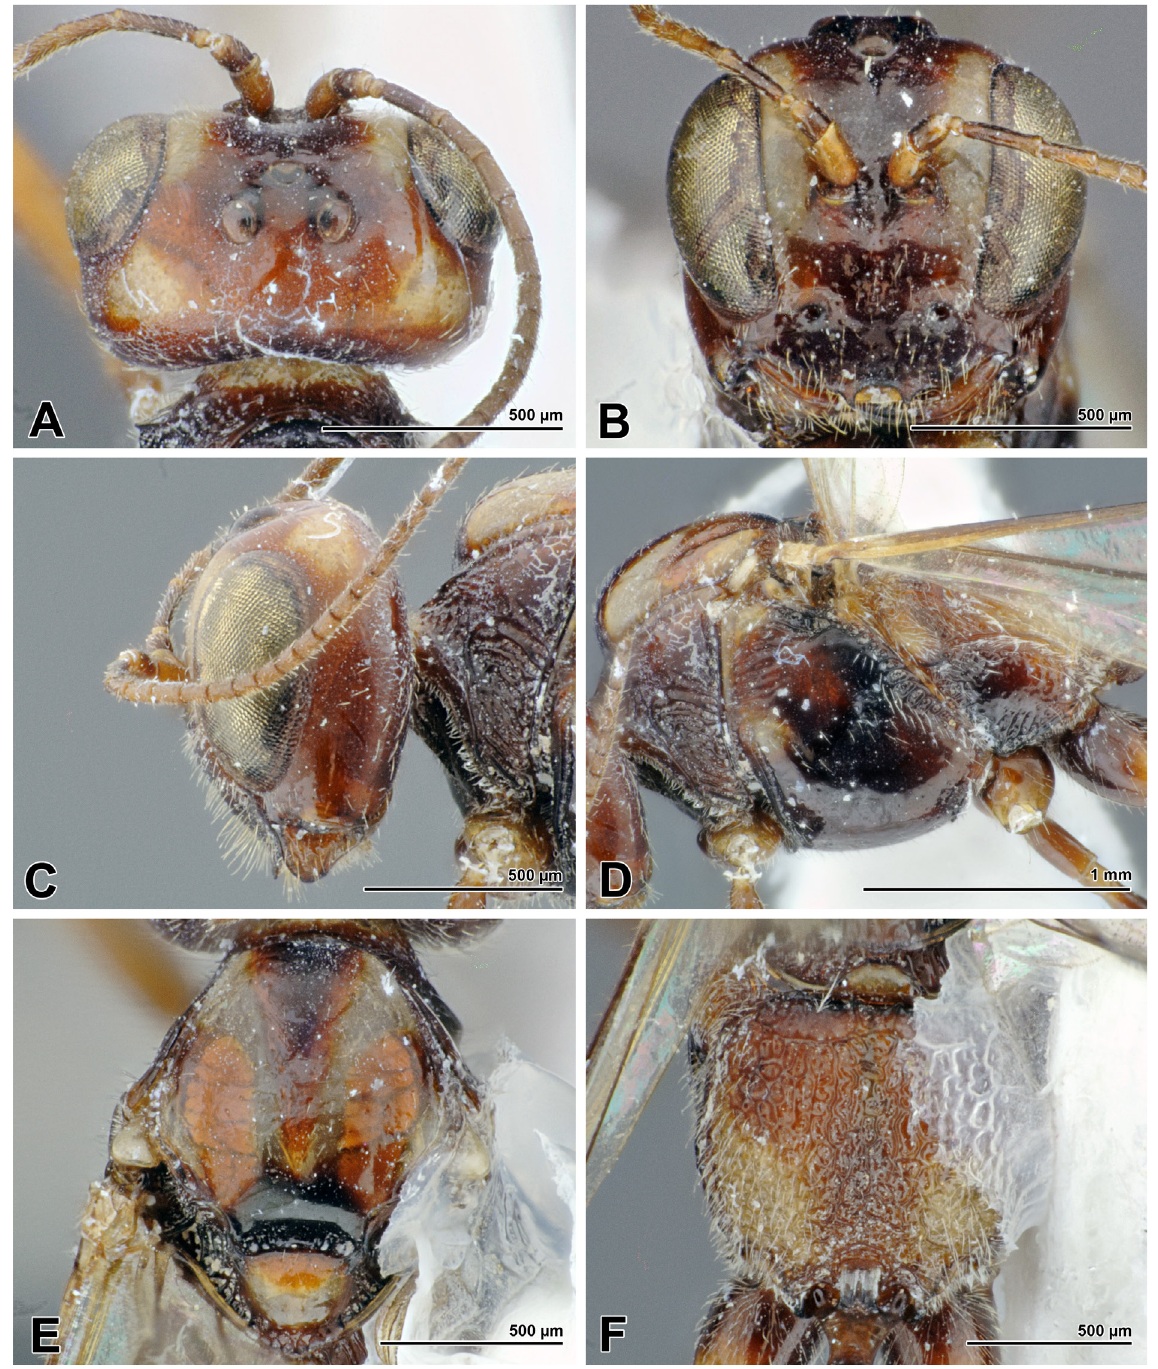
Fig. 2. Anomalon amseli (Hedwig, 1961), ♀, DPPZ. A . Head, dorsal view. B . Head, frontal view. C . Head, lateral view. D . Mesosoma, lateral view. E . Mesoscutum, dorsal view. F . Propodeum, dorsal